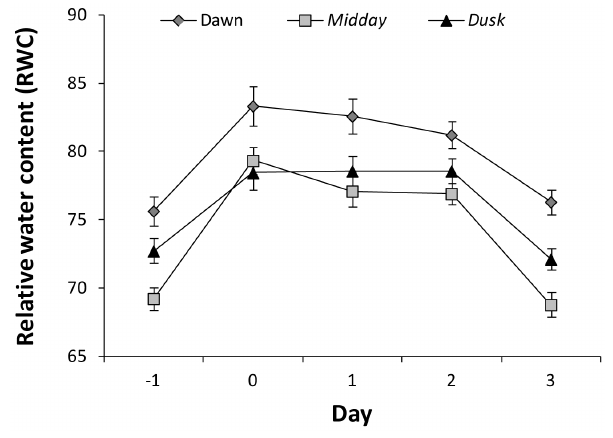
Figure 6. Relative water content of leaves of C.procera plants taken at dawn, midday and one hour pre-dusk one day before watering and up to three days after watering.